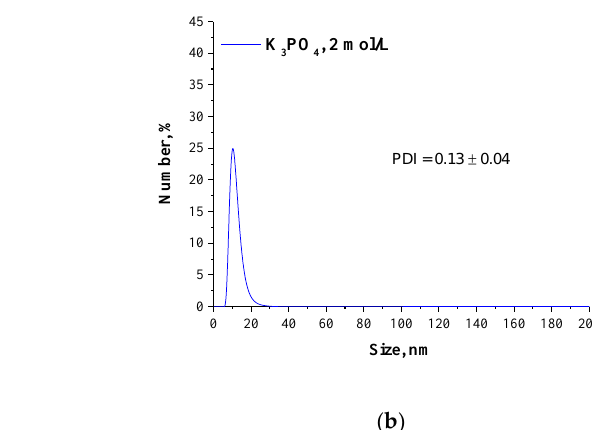
Figure 3. DLS analysis of particles obtained using Tris-HCl buffer with pH = 7 and 1 mol/L K 3 PO 4 ( a ) or 2 mol/L K 3 PO 4 ( b ) as a salting-out agent.